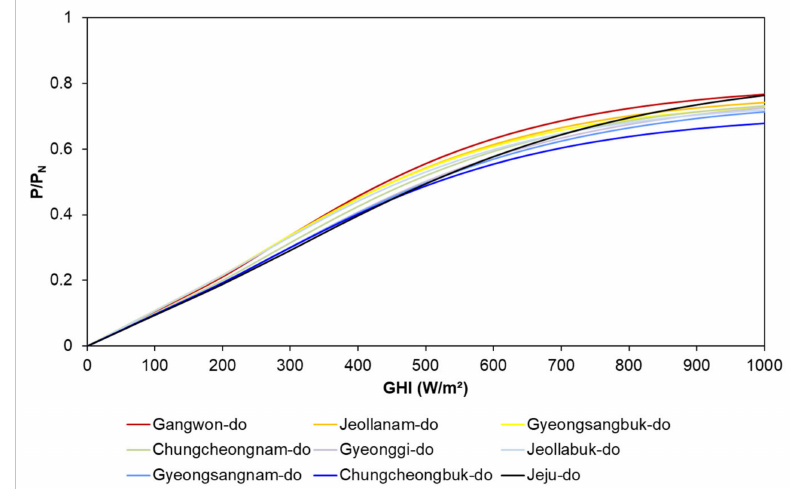
Figure 6. Comparison of the Gompertz curves by province (for 2014~2016).